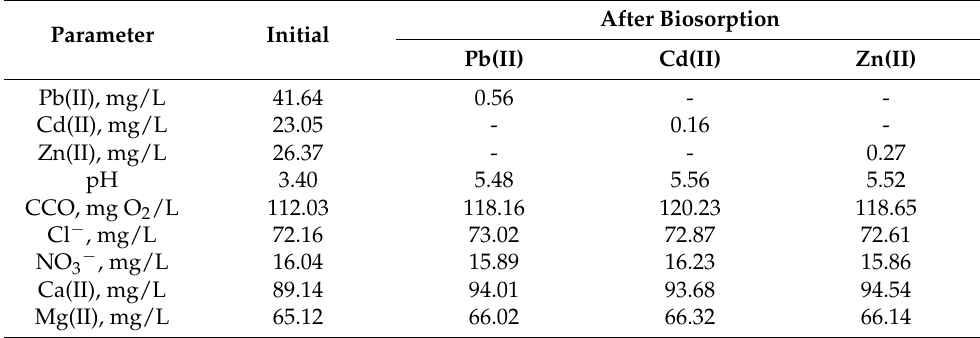
Table 5. Parameters of the artificial wastewater before and after the treatment with Na-SW biosorbent.